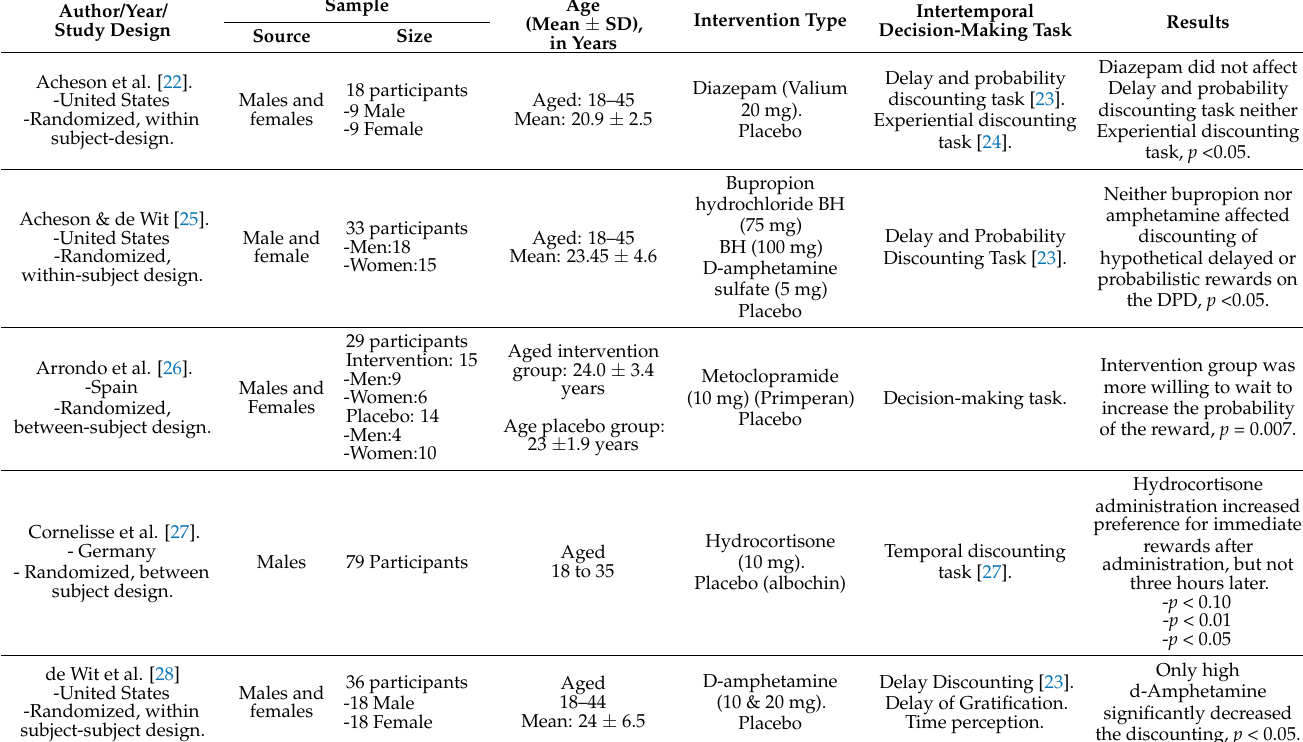
Table 1. Summary of characteristics and results of included